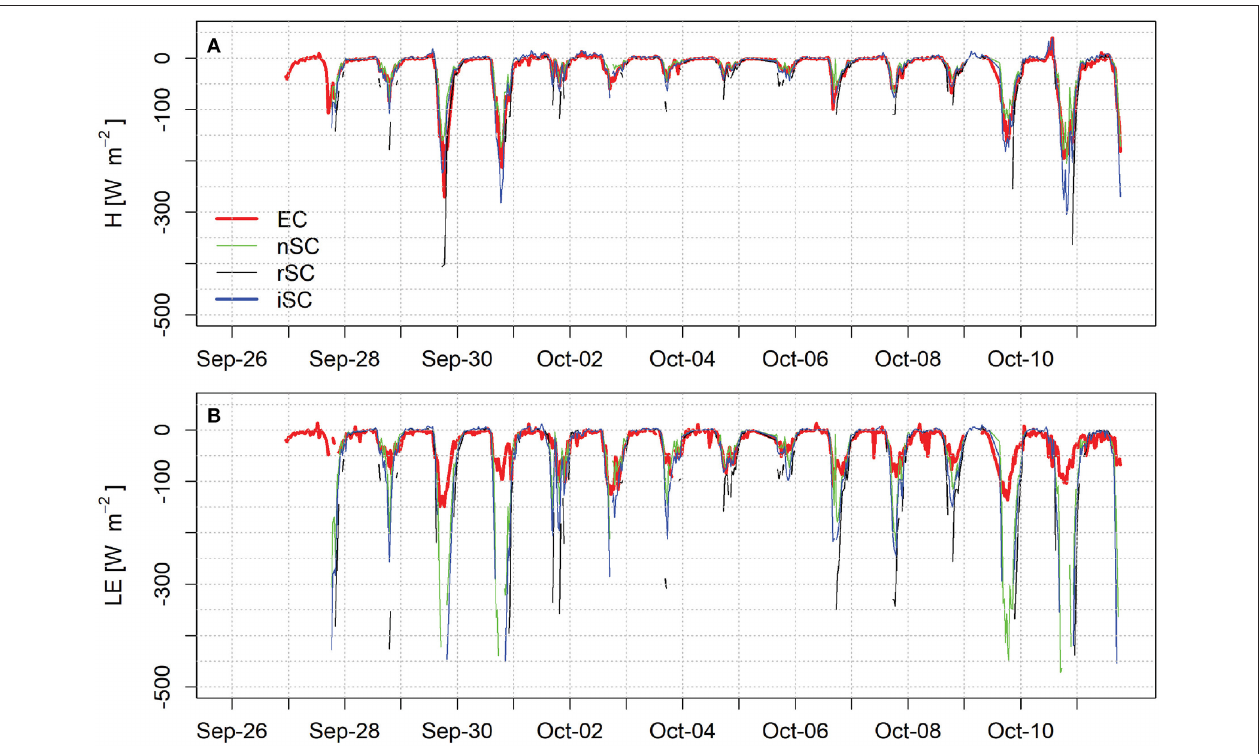
FIGURE 8 | Model results for all bulk models over the whole study period for (A) sensible heat flux and (B) latent heat flux. EC denotes the eddy correlation measurements, nSC the model with no stability correction, rSC based on the Richardson number and iSC iterating over the Monin-Obukhov length. Timesteps with no data for a model are cases where it was below –500 W m − 2 .